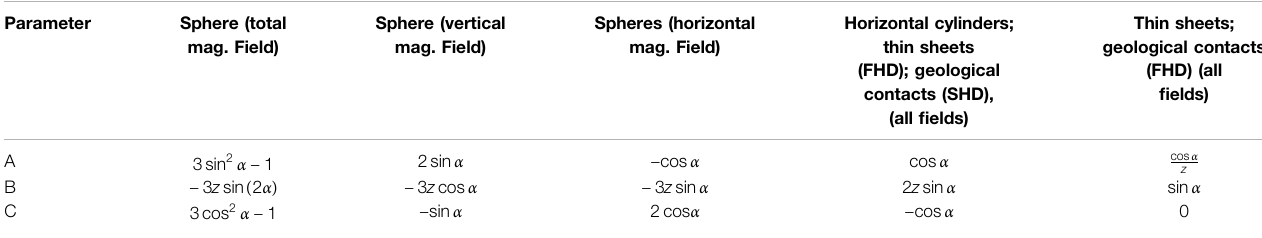
TABLE 2 | De fi nitions of A, B and C parameters. Parameter Sphere (total